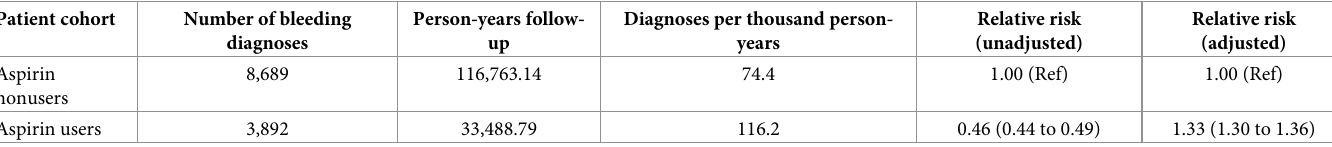
Table 5. Counts of bleeding episodes among aspirin users and nonusers over